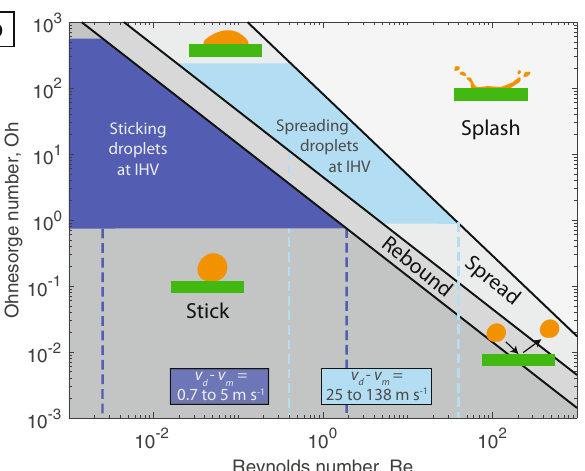
Fig. 5 Regime diagrams for melt removal and addition during the eruption of low viscosity magmas. a The differential velocity between the gas and homogeneous melt layer against the critical Kelvin – Helmholtz instability wavelength. The four curves show results for four different surface tensions reasonable for melts spanning the ultrama fi c to ma fi c compositional spectrum 6, 62, 63 . The dashed red lines mark the observed range in olivine crystal long axis values and the solid red line denotes the mean. b Droplet impact regime diagram, relating the impact conditions (Re) to the physical properties of the droplets (Oh). The two shaded regions in dark and light blue correspond to the observed droplet size distribution of both the sticking and spreading droplets respectively (cf. Fig.